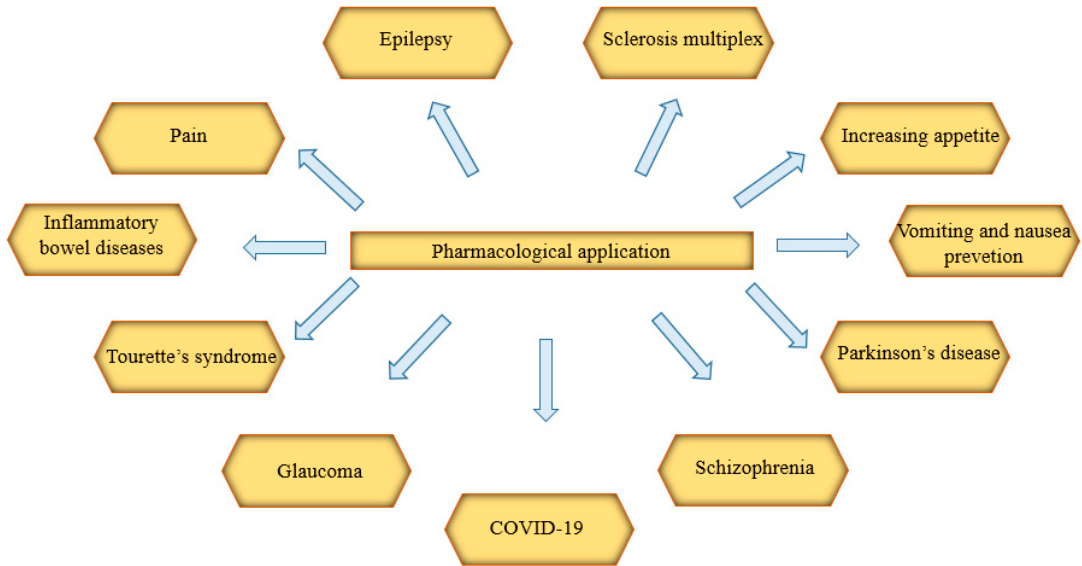
Figure 9. Pharmacological applications of extracts or drugs from Cannabis sp. or synthetic cannabinoids in diseases. COVID-19: coronavirus disease 2019.